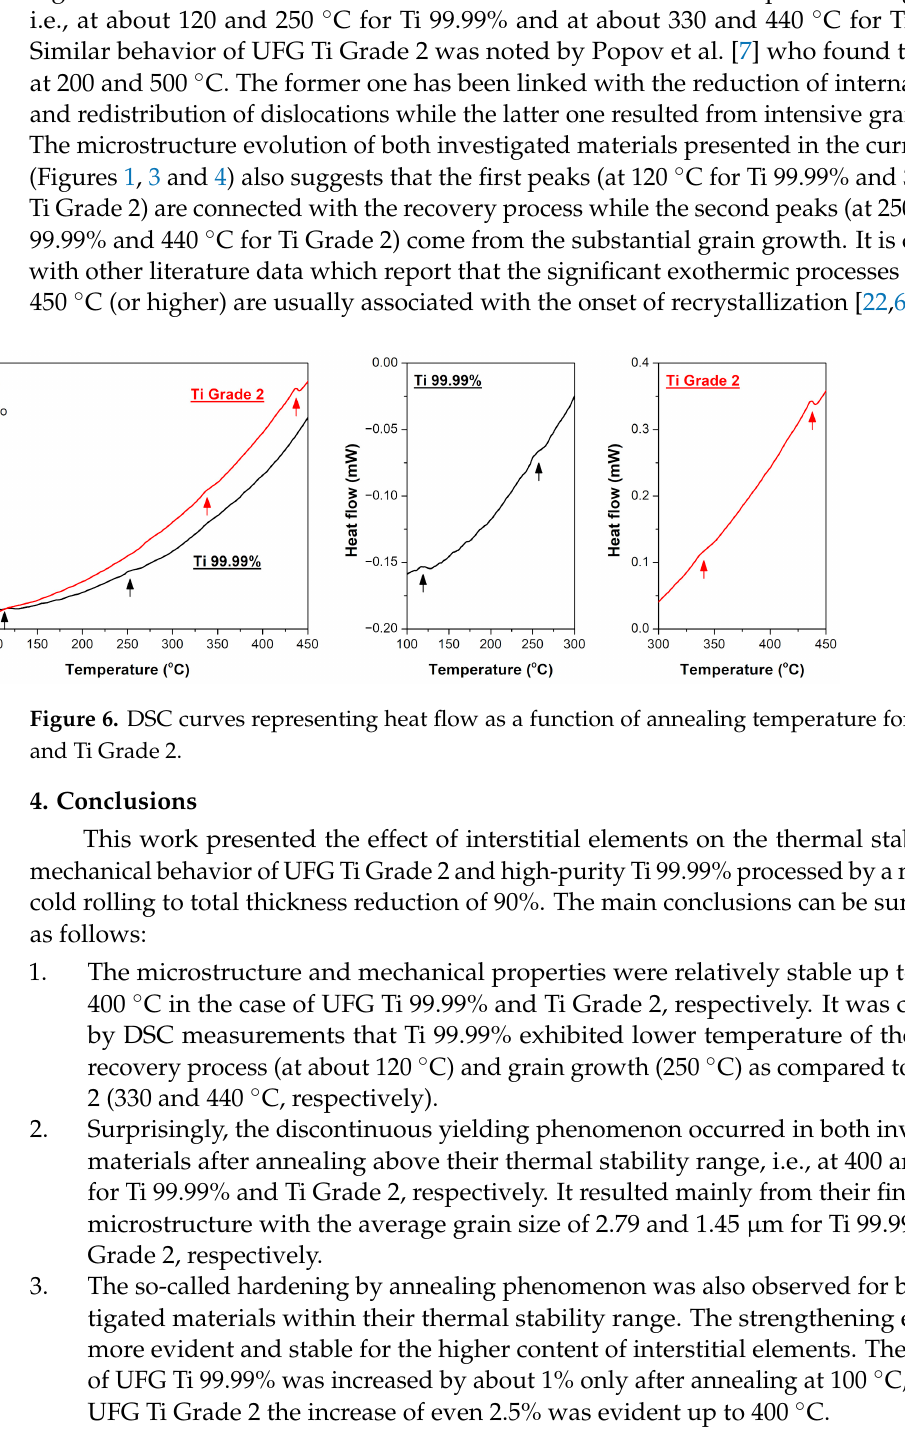
Figure 6. The as-rolled Ti 99.99% and Ti Grade 2 exhibited two peaks during heating, i.e., at about 120 and 250 ◦ C for Ti 99.99% and at about 330 and 440 ◦ C for Ti Grade 2.